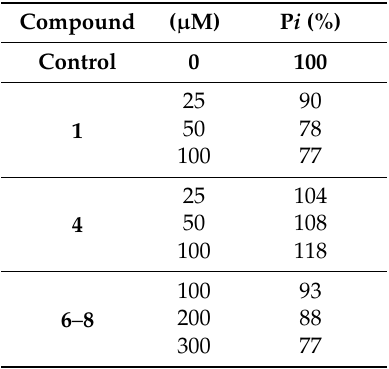
Table 1. Effect of Compounds 1 , 4 , and 6 – 8 on inorganic phospate (P i ).